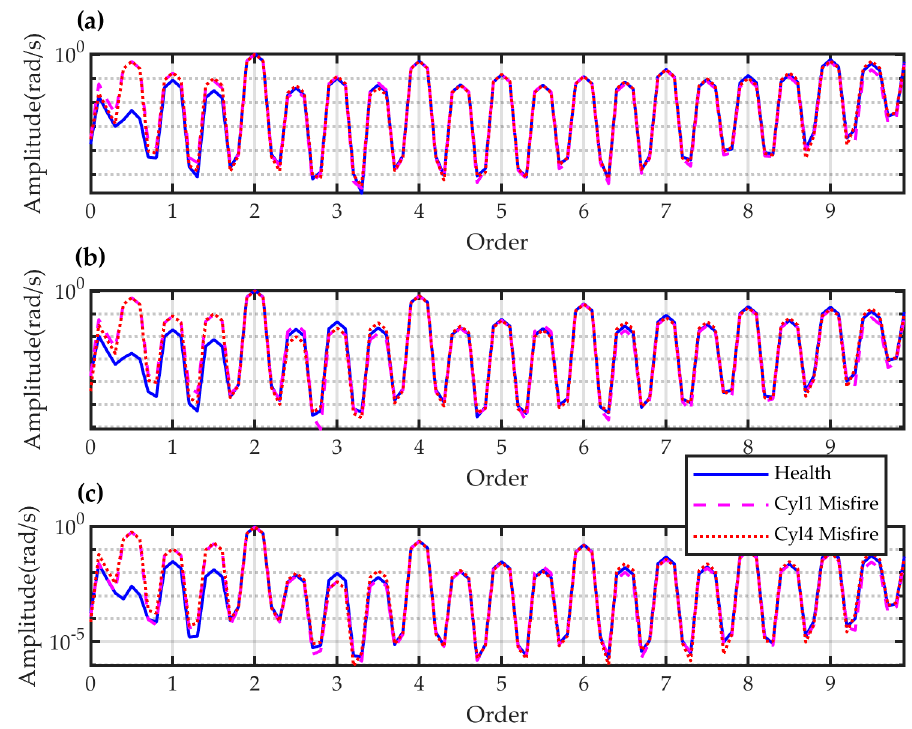
Figure 12. Order spectrum of the IAS signals at: ( a ) the pulley; ( b ) the flywheel; ( c ) coupling. The mean squared error ( MSE ) is used to quantify the variation induced by the misfire faults at four cylinders.